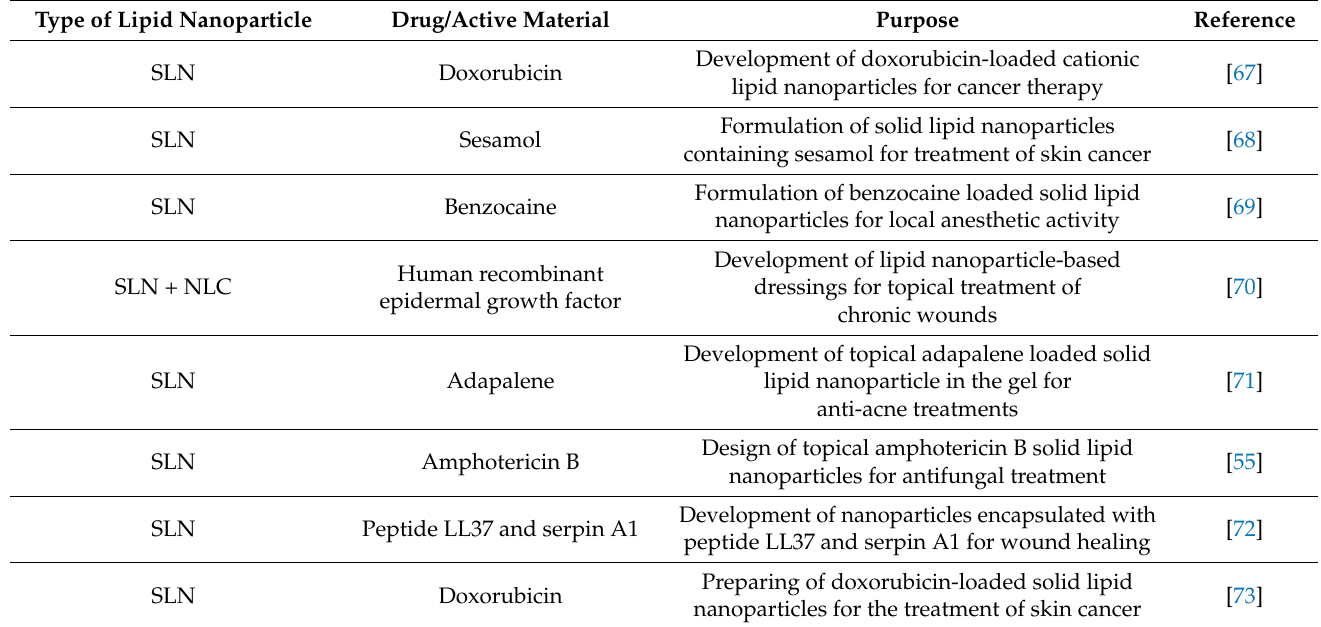
Table 1. Recent studies on dermal/transdermal drug delivery systems comprising NCL and SLN. Type of Lipid